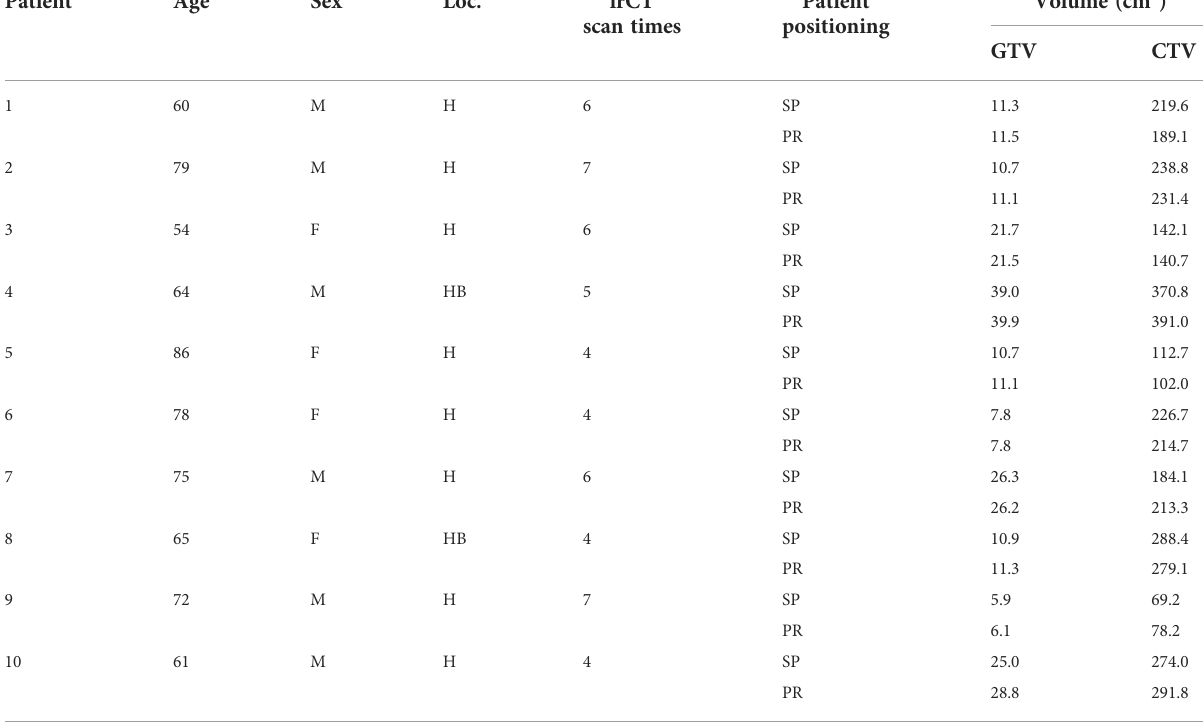
TABLE 1 Patient